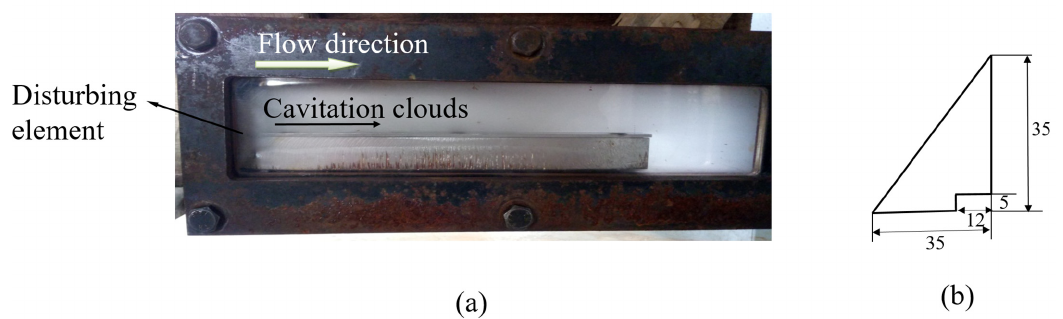
Figure 3. ( a ) Cavitation flows in the experimental section. ( b ) Shape of the disturbing